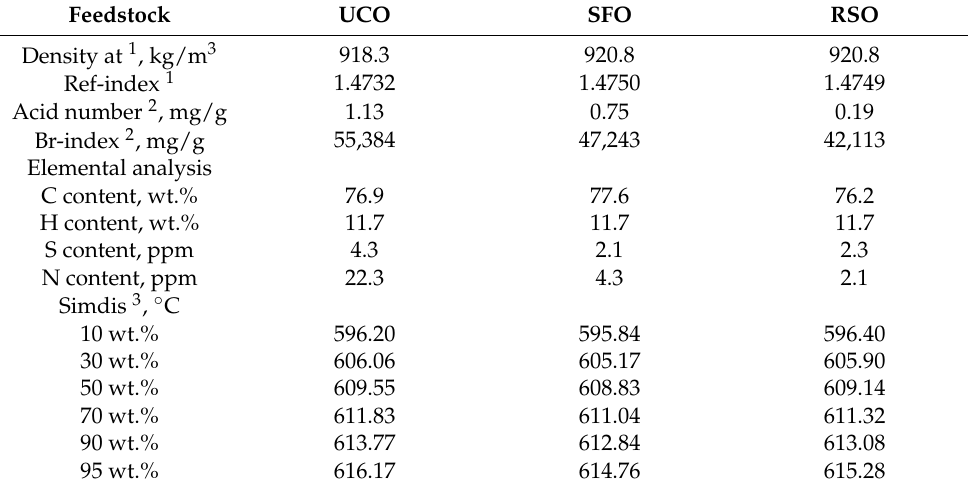
Table 1. Basic feedstock properties.